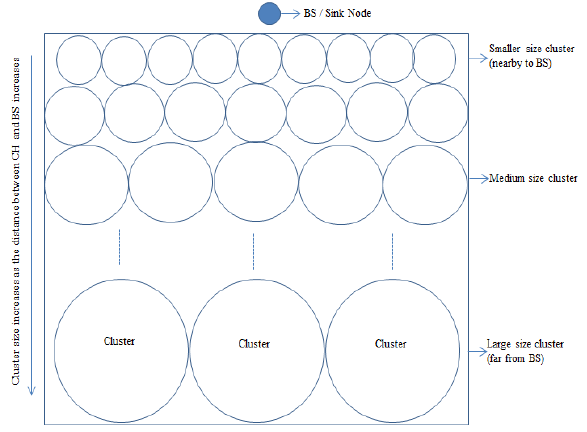
Figure 16. Architecture of unequal clustering in